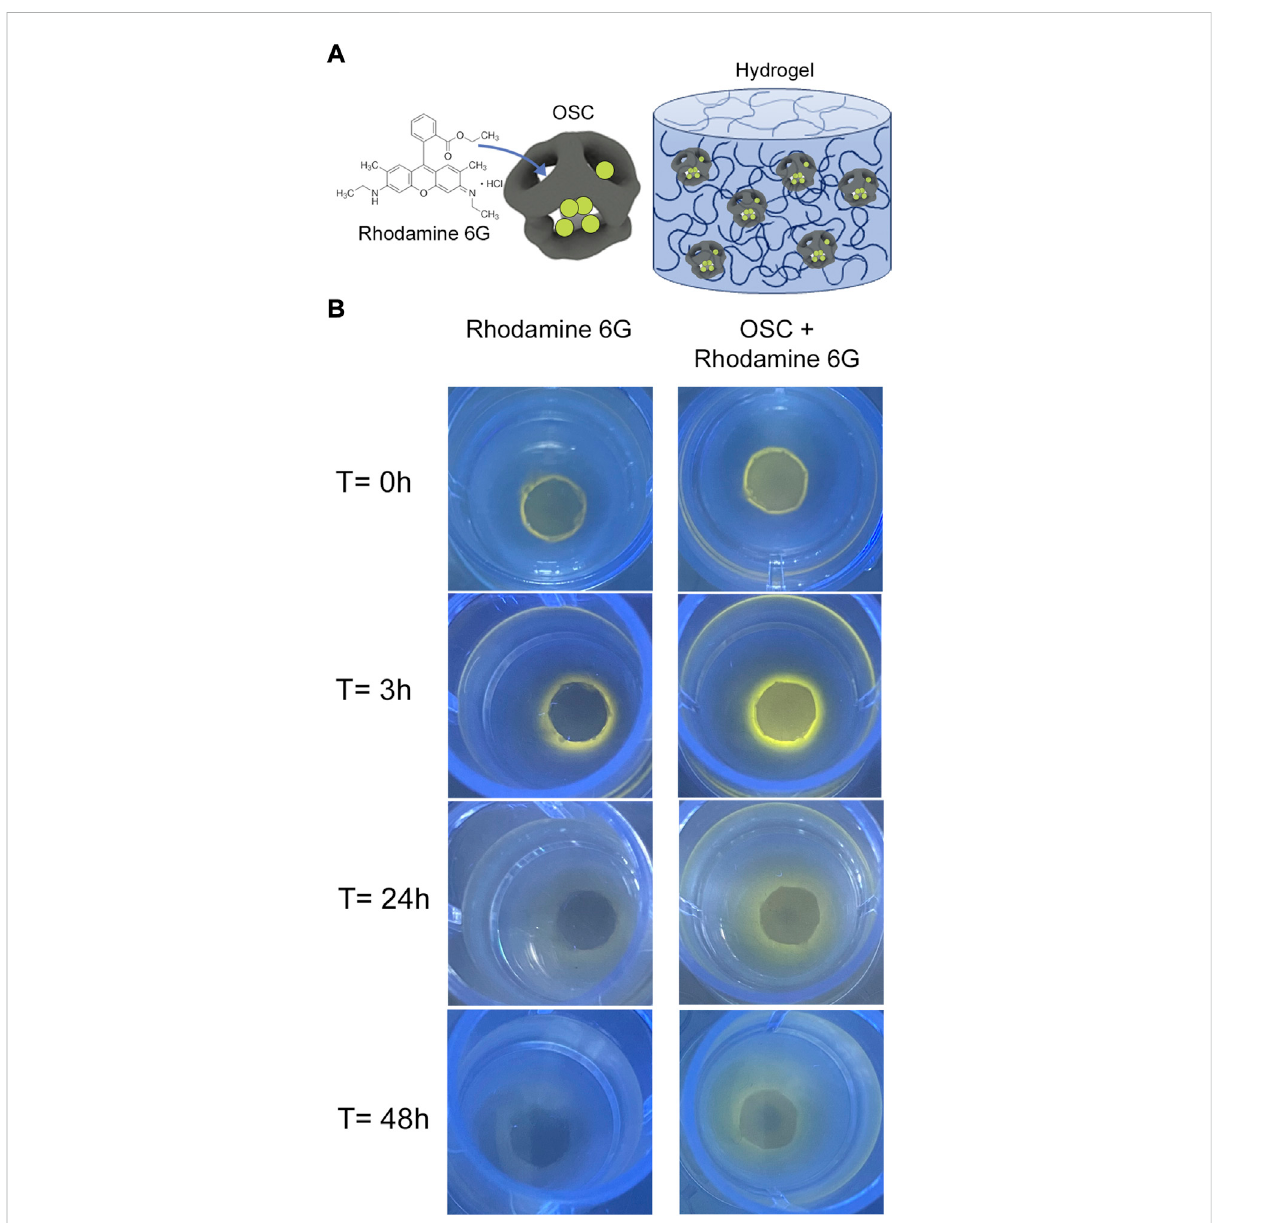
FIGURE 2 Rhodamine6GreleasefromOSCincorporatedpolyacrylamidehydrogels. (A) Schematicdepictinghydrogeldesign.Rhodamine6Gwasloaded into OSCs, following by physical entrapment in UV crosslinked polyacrylamide hydrogels. (B) Release of rhodamine 6G from hydrogels. Rhodamine 6G control hydrogels are compared to rhodamine 6G-loaded OSC incorporated hydrogels. At t = 0, rhodamine 6G control and OSC hydrogels are crosslinked into the center of the molds. At t = 3 h, the release of rhodamine 6G from control hydrogels is obvious as the dye can diffuse out of the gel through the network mesh and as the gel swells. In the OSC-rhodamine hydrogels, very little diffusion is evident. 24 h after crosslinking control hydrogels have very low amounts of rhodamine visible, while the OSC-rhodamine hydrogels still have rhodamine in the center and around the crosslinked hydrogel. At 48 h, there is nearly no rhodamine visible in the control hydrogels, while rhodamine 6G is still visible in the center the OSC-rhodamine crosslinked hydrogels and throughout the hydrogel